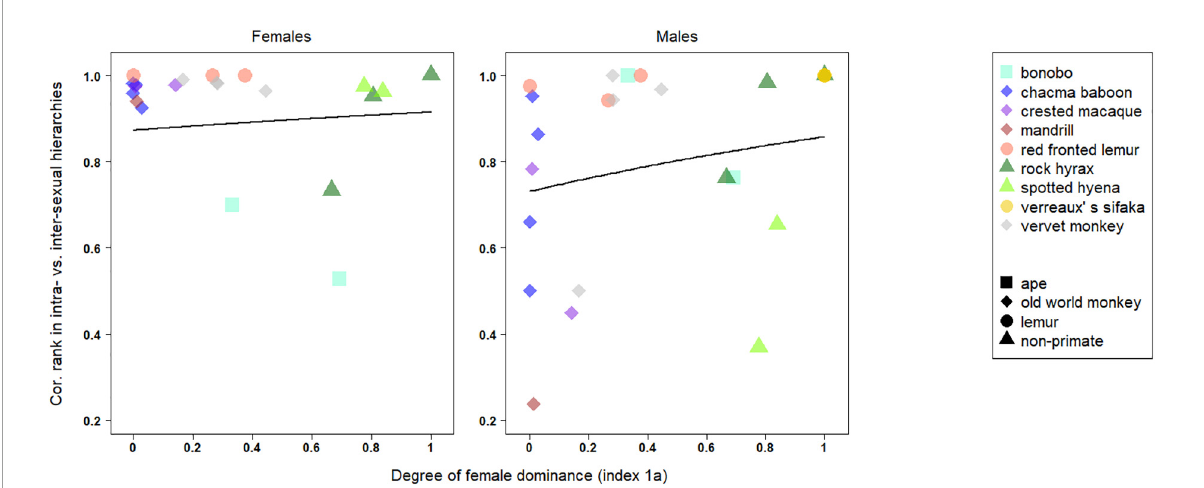
FIGURE3 Degree of female dominance and correlation between intra- and intersexual hierarchies for females (left panel) and males (right panel). Each species is depicted using a different color. Apes, old world monkeys, lemurs and non-primates are depicted using squares, diamonds, circles and triangles, respectively. Each dot represents one study group in a given year. The black lines indicate the model’s predictive lines for the effect of the degree of female dominance on the correlation between individual ranks from the intra- and from the intersexual hierarchies for females (Model 1a, left panel) and for males (Model 1b, left panel). The lines are only indicative since the p -values for these effects were non-significant in both models. Verreaux’s sifakas do not appear in the left panel since there was only one female in each of the three groups and correlations between female ranks in the intra and intersexual hierarchies could thus not be